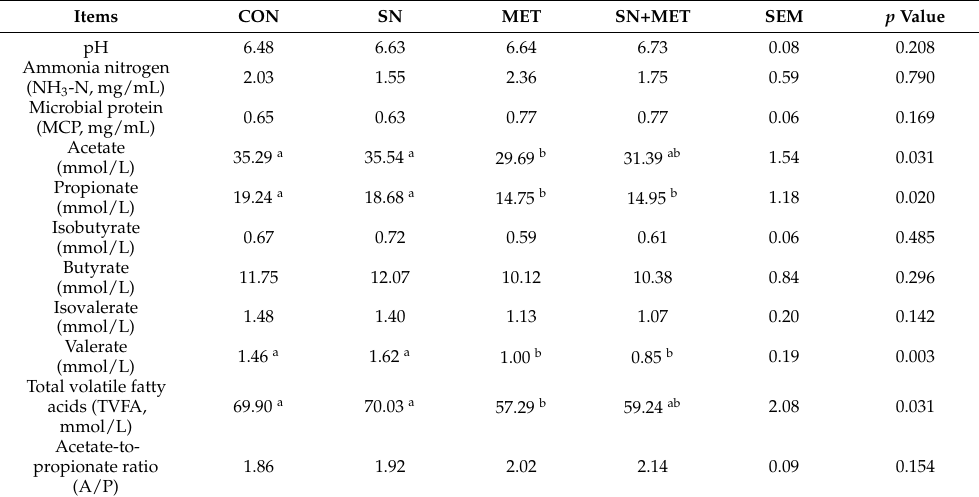
Table 3. Effects of sodium nitrate and methionine on rumen fermentation parameters (N = 10).